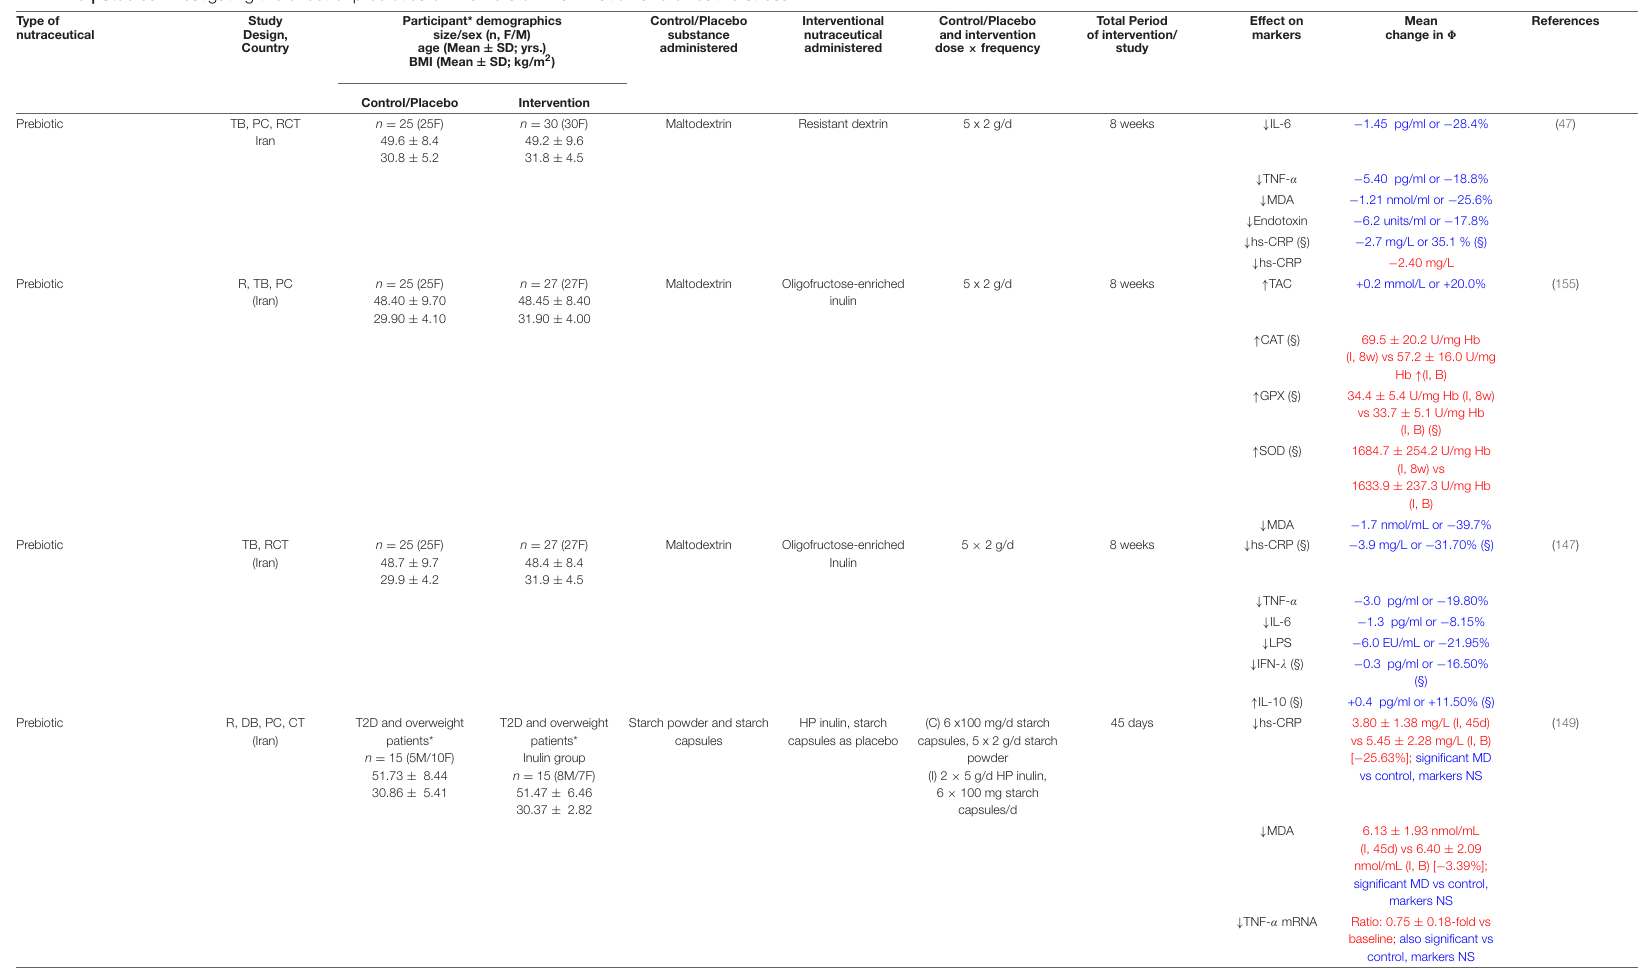
TABLE 3 | Studies investigating the effect of prebiotics on markers of inflammation and oxidative stress in T2D.